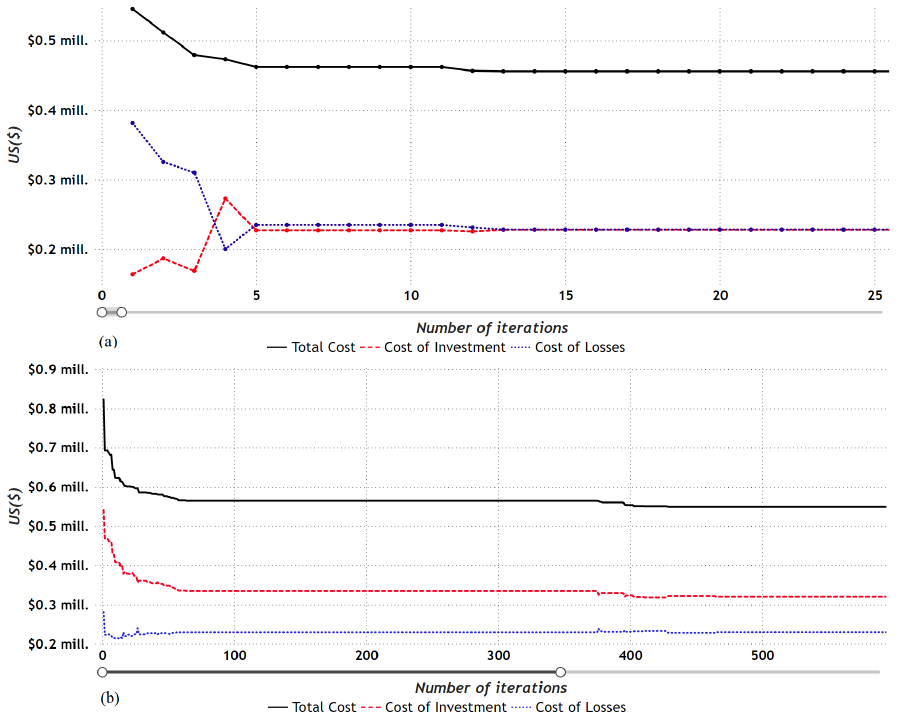
Figure 18. Behavior of the value of the objective function for: ( a ) 8-bus system with balanced load; ( b ) 27-bus system with balanced load.